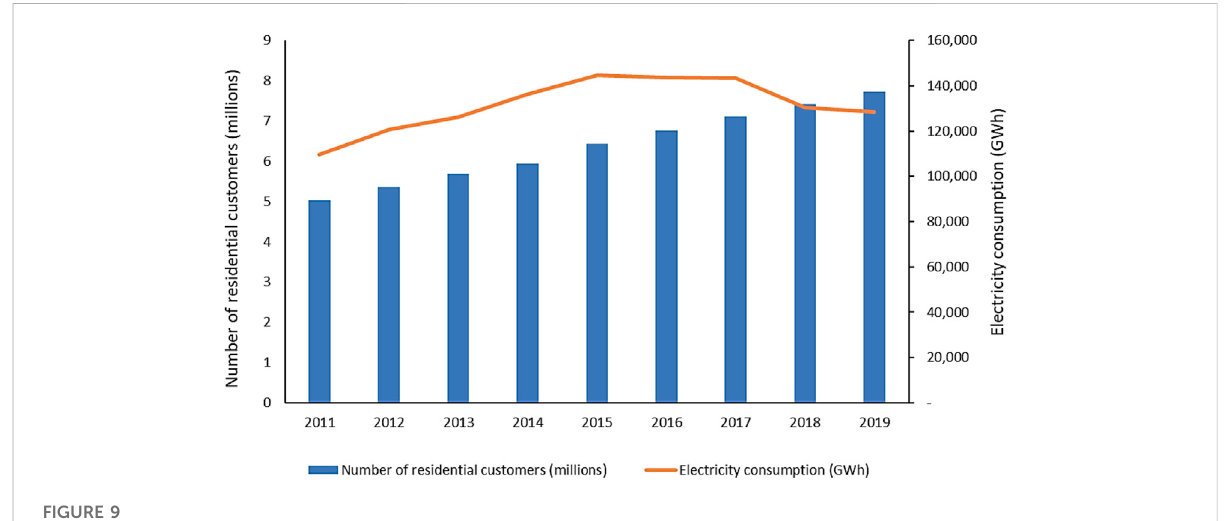
FIGURE 9 Residential sector: number and